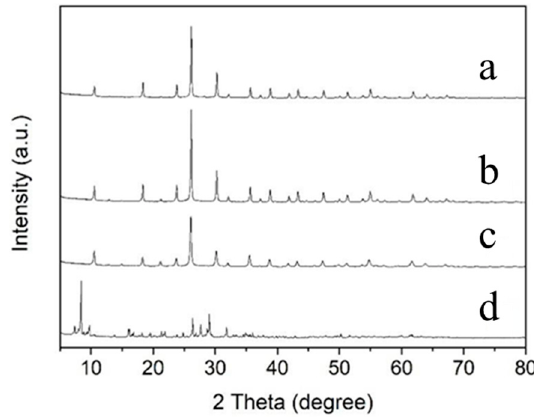
Figure 1. X-ray diffractometer patterns of the Cs 6 PV 3 MoW 8 O 40 ( a ); Cs 4 H 2 PV 3 MoW 8 O 40 ( b ); Cs 2 H 4 PV 3 MoW 8 O 40 ( c ); and H 6 PV 3 MoW 8 O 40 ( d Cs 2 H 4 PV 3 MoW 8 O 40 ( c ); and H 6 PV 3 MoW 8 O 40 ( d ).